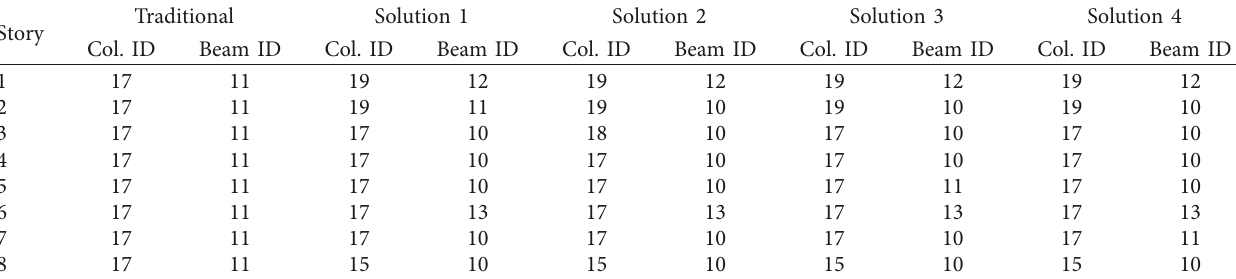
Table 4: Design results for the 8-story